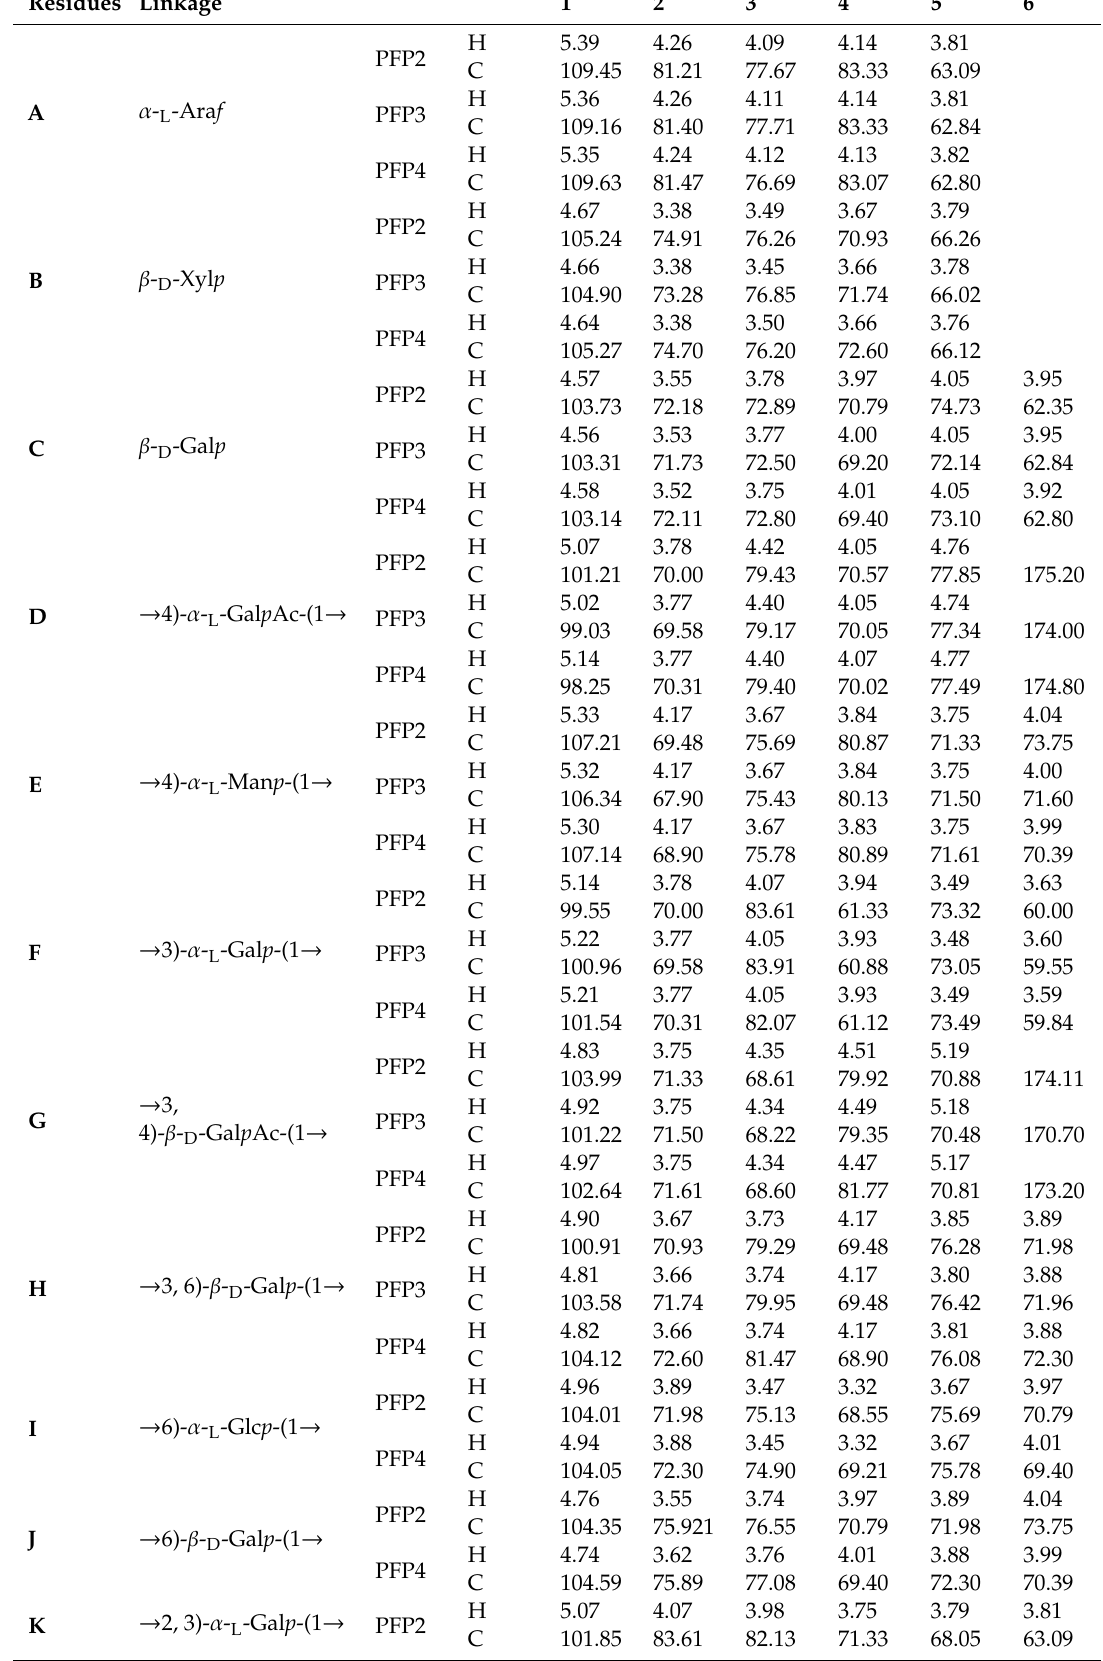
Table 3. 1 H and 13 C NMR Spectral assignments for PFP2, PFP3, and